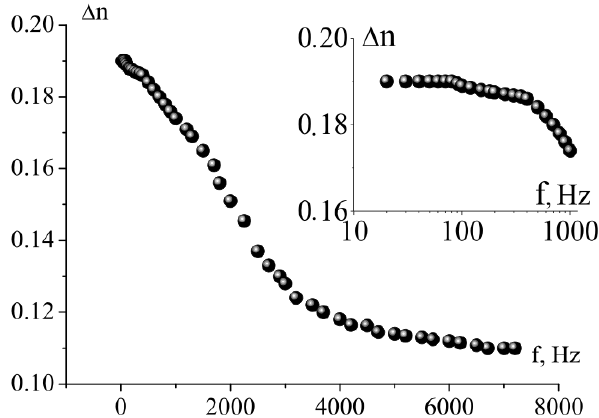
Figure 10. Frequency dependence of the birefringence of the HF-32C composition. Inset: a low-frequency part of this dependence. The thickness of the electro-optical cell is 1.7 μm. The amplitude of the bipolar control voltage (meander) is ±1.5 V.